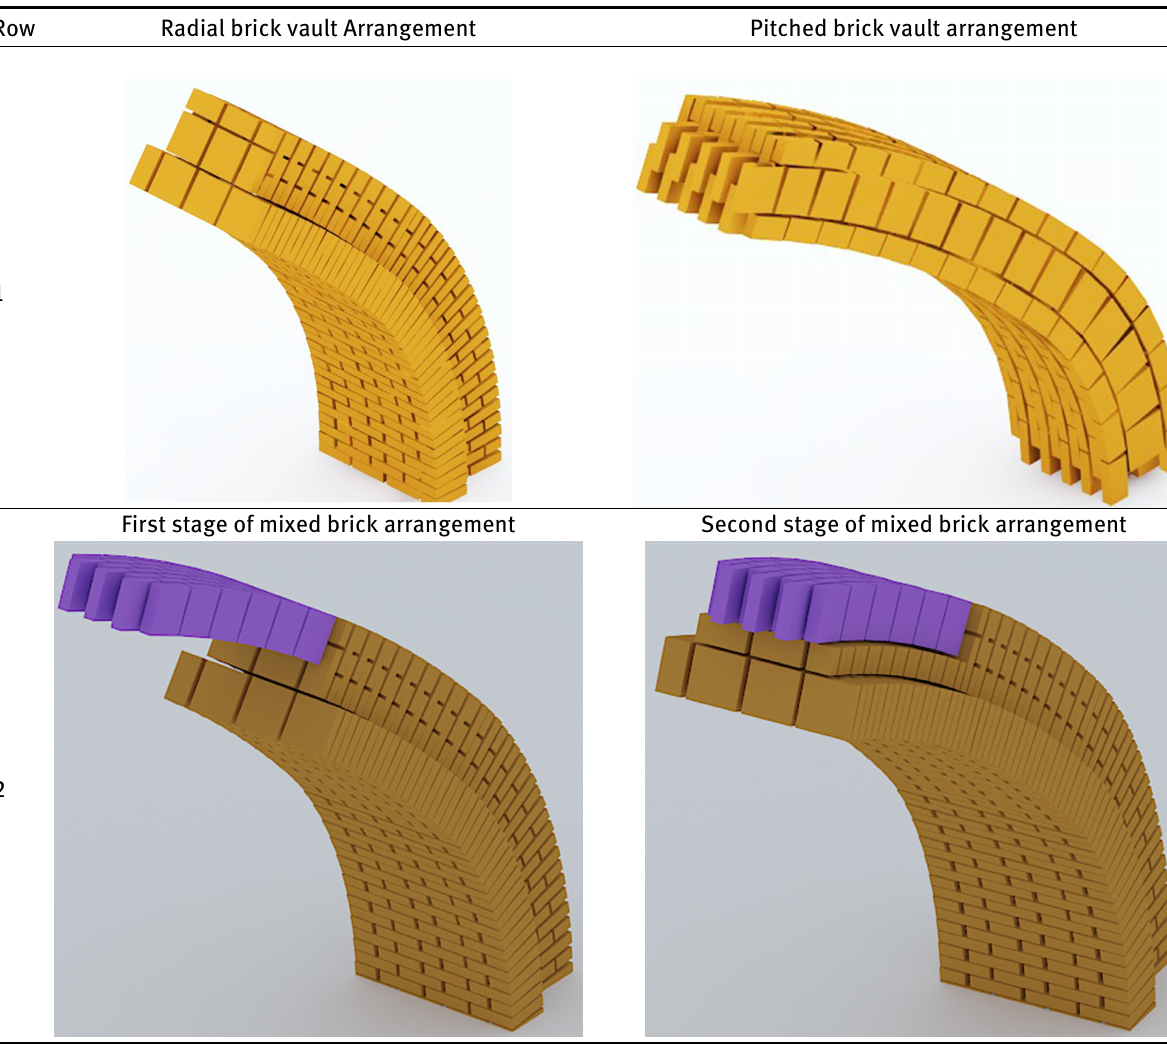
Table 1: Brick arrangement in the three methods of masonry ribs implementation